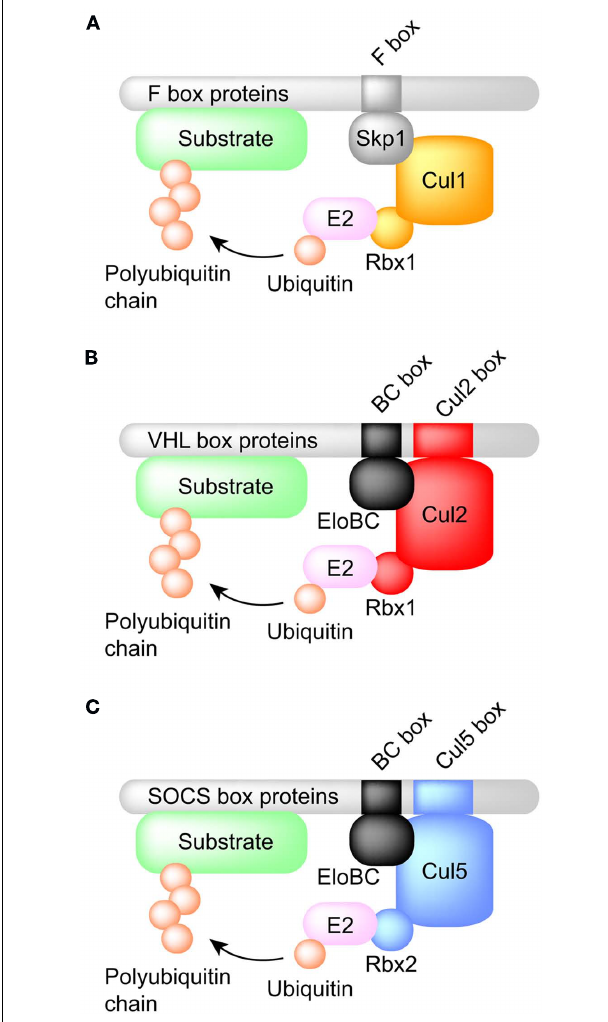
FIGURE 1 | Comparison of the structures of SCF- and ECS-type ubiquitin ligases. (A) SCF-type ubiquitin ligases. Cul1 is used as a scaffold protein and Skp1 bridges the gap between the F box protein and Cul1. (B) Cul2-type ubiquitin ligases. Cul2 is used as a scaffold protein and the Elongin BC complex connects theVHL box protein to Cul2.The Cul2 box determines the use of Cul2 as the scaffold protein. (C) Cul5-type ubiquitin ligases. Cul5 is used as a scaffold protein. Note that the Rbx2 is used for the recruitment of E2 enzyme.